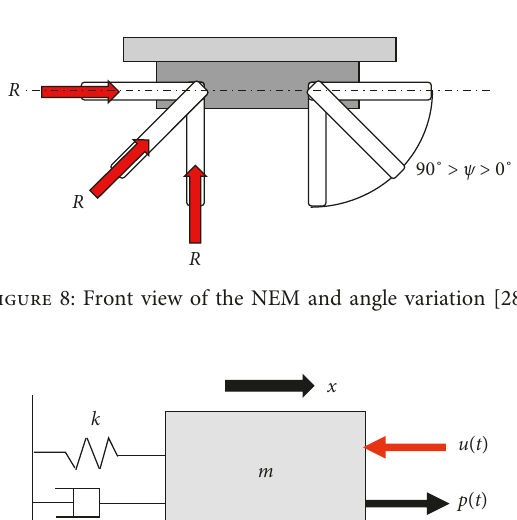
Figure 7: Side view of the NEM and resultant force R (vertical line only). (a) Central sectional drawing of the NEM bridge. (b) Resultant force of the NEM.